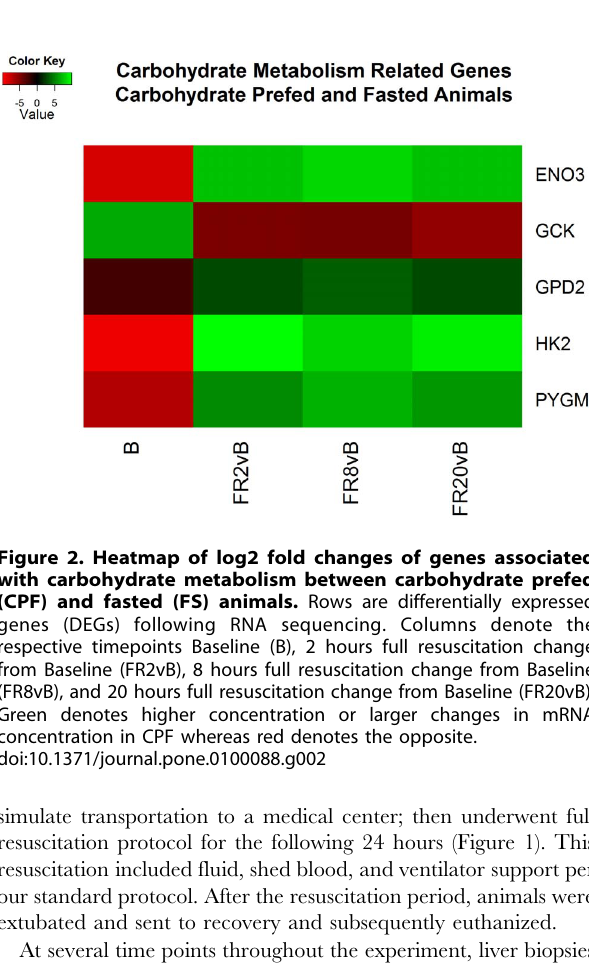
Table 1. Number of differentially expressed genes between CPF and FS animals and between timepoints within groups.